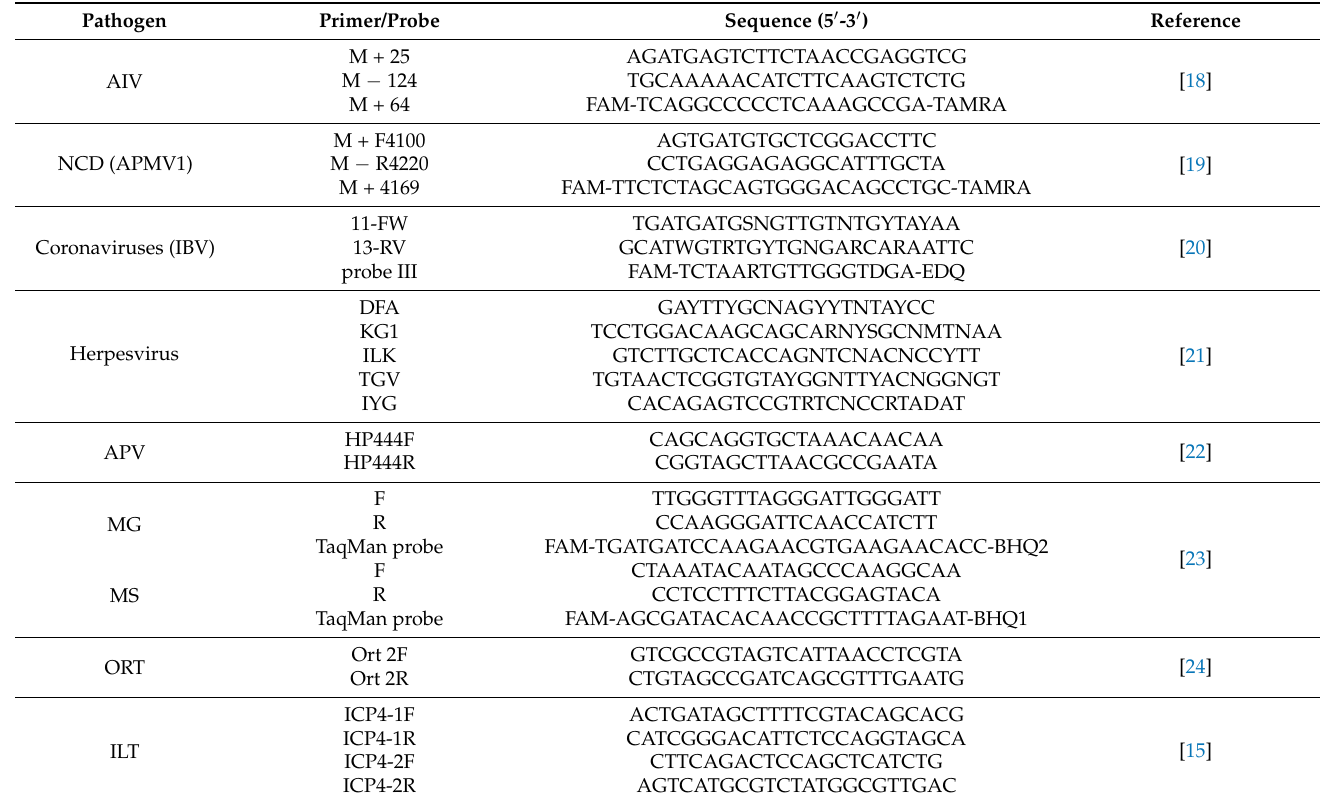
Table 2. Primers sequences used for molecular detection of respiratory